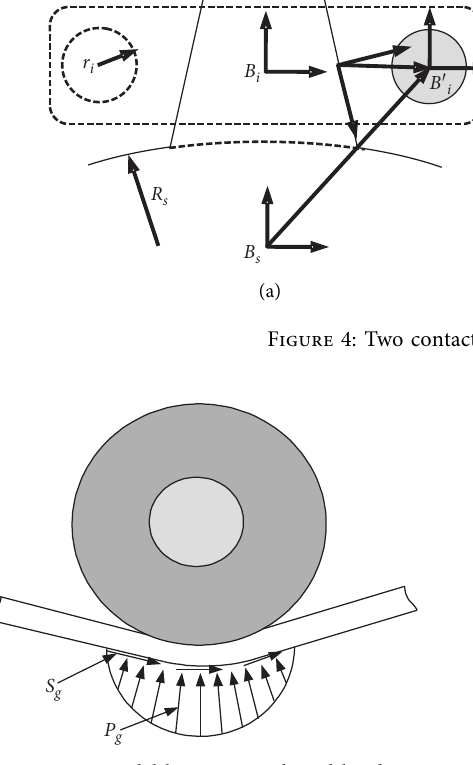
Figure 5: Contact model between track and hard pavement.